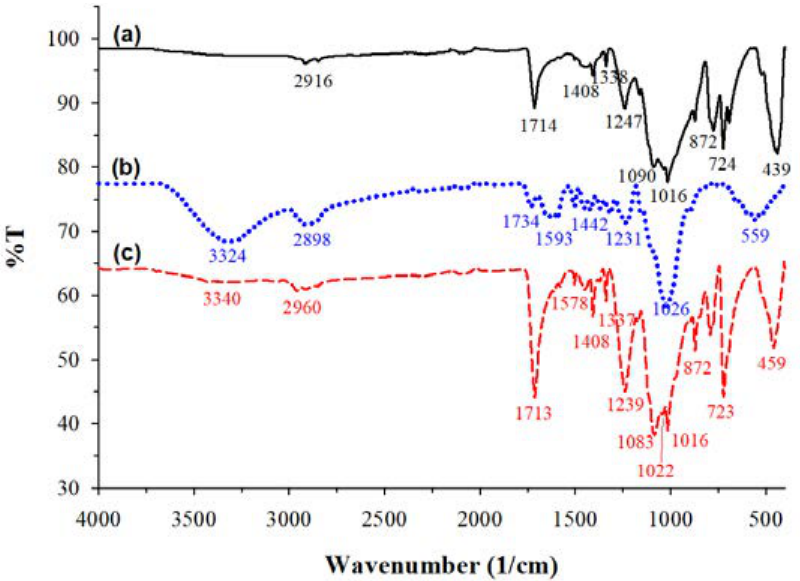
Fig. 2: IR spectra of samples; (a) PET waste, (b) biomass, and (c) PET/biomass pellets